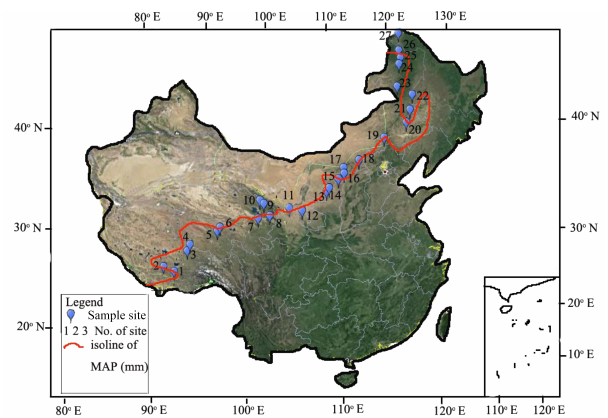
Figure 1. Sketch of the sampled region. Sample sites are indicated